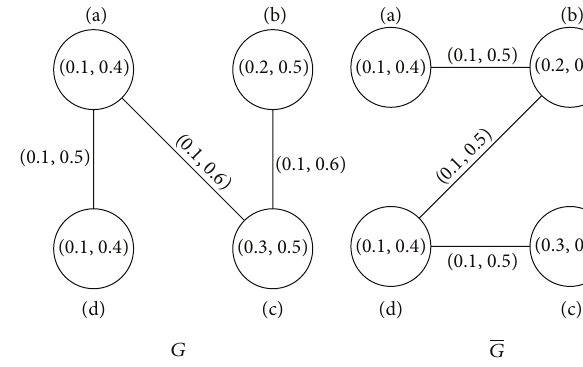
Figure 11: 𝐺 and 𝐺 are irregular and totally irregular. Figure 12: 𝐺 and 𝐺 are irregular and totally